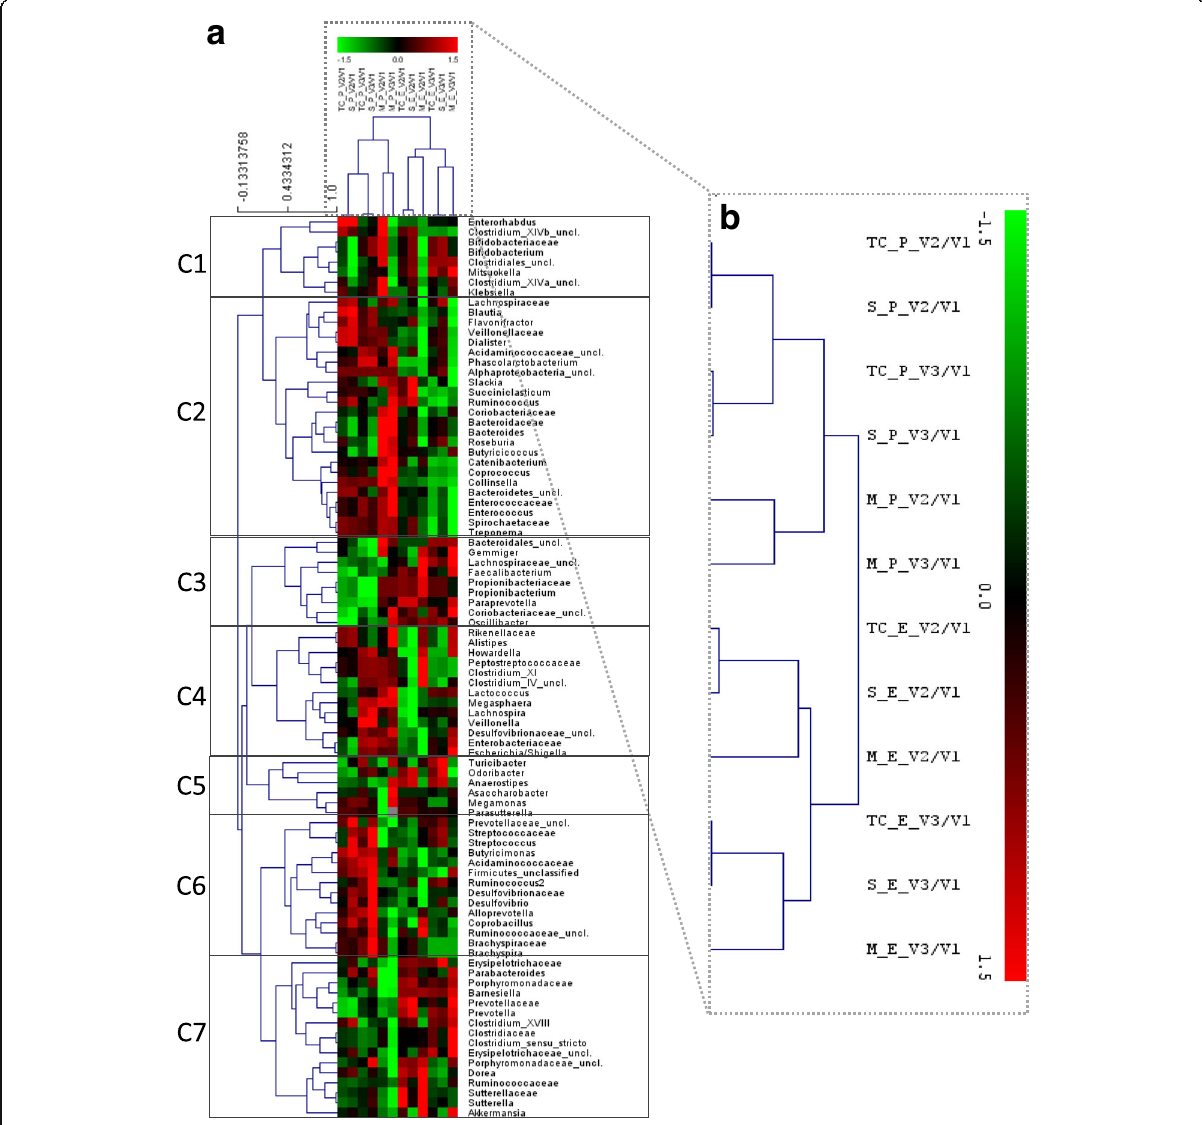
Fig. 9 Hierarchical clustering heatmap of the Log2 relative fold-changes calculated for all taxonomic groups (family and genus levels). ( a ) Both taxa and treatment groups were subject to HCL analysis. ( b ) Shows a detail of the results for the groups ’ HCL. The KMC analysis roughly revealed the presence of 7 major clusters (C1-C7) based on similarly of taxa relative fold-changes. Legend: C, cluster; E, Epicor; M, moderate subgroup, P, placebo; S, severe subgroup; TC, total cohort; V,